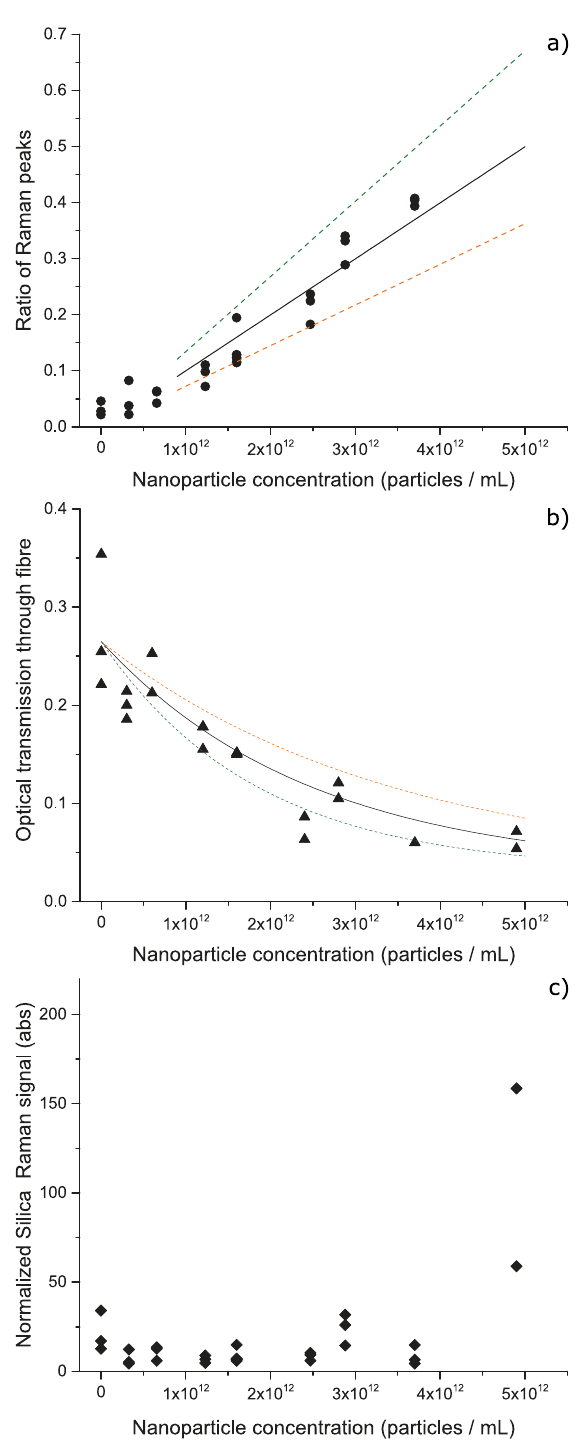
Figure 7. Experimental measurements on PS60 nanoparticles in aqueous solution. ( a ) Variation of Raman peak ratio with nanoparticle concentration. Measurements (circles), simulation for 63 nm (solid line), 58 nm (orange dashed line) and 68 nm (green dashed line). ( b ) Variation of optical power transmitted through the optical fiber (measurements shown as triangles) with simulation results for particles with diameter of 63 nm (solid line), 58 nm (orange dashed line) and 68 nm (green dashed line). ( c ) Variation of the peak height of silica at 490 cm − 1 normalized to the peak height of the O–H stretching mode, for increasing concentrations of